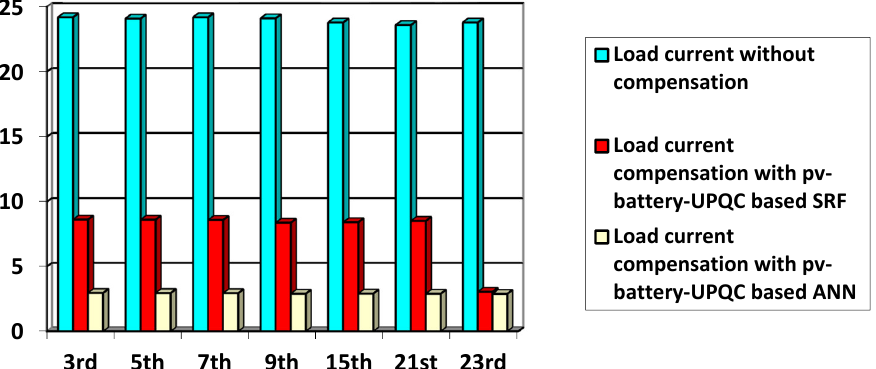
Figure 22. THD values of source and load current before and after compensation of PV-battery-UPQC based on SRF and ANN control techniques.